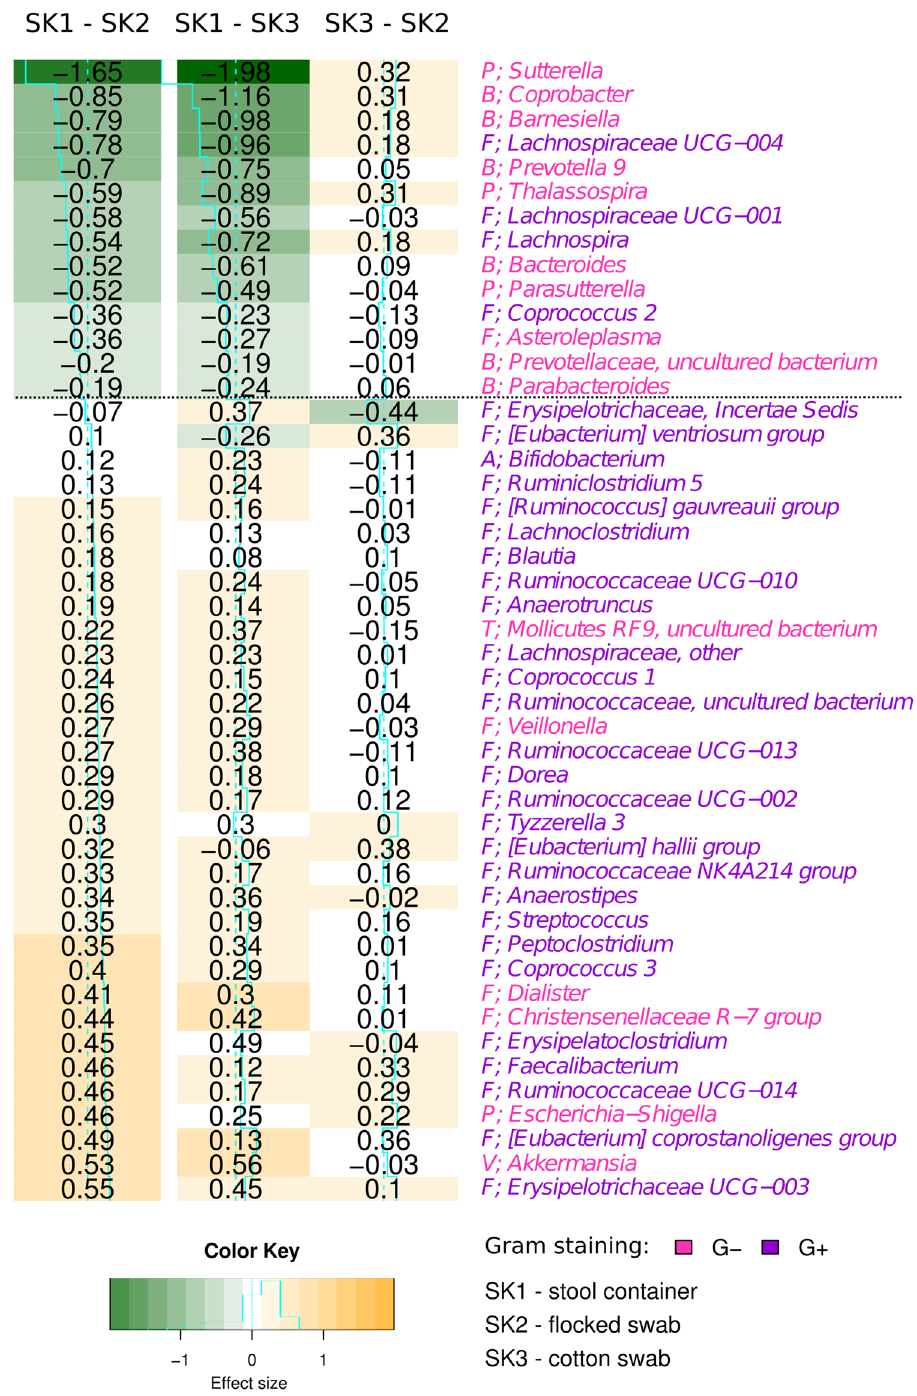
Figure 4. Comparison of sampling kits effects at genus level. Each column corresponds to a pair of sampling kits and each row corresponds to a specific bacteria genus. The values represent log fold changes of bacterial abundances (effect size) between the sampling kits, color coded from green (less abundant) to orange (more abundant). Only significantly affected taxa are